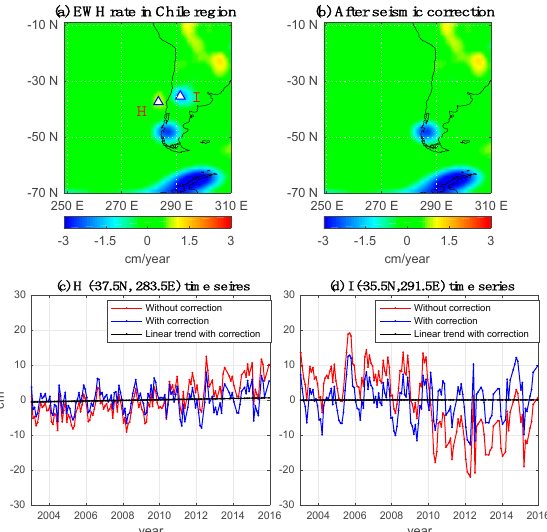
Figure 4. ( a ) The EWH rate distribution in the Tohoku-Oki earthquake region, ( b ) the rate distribution after the seismic effect correction, ( c ) the time series at the point F (36.5°N, 144.5°E), and